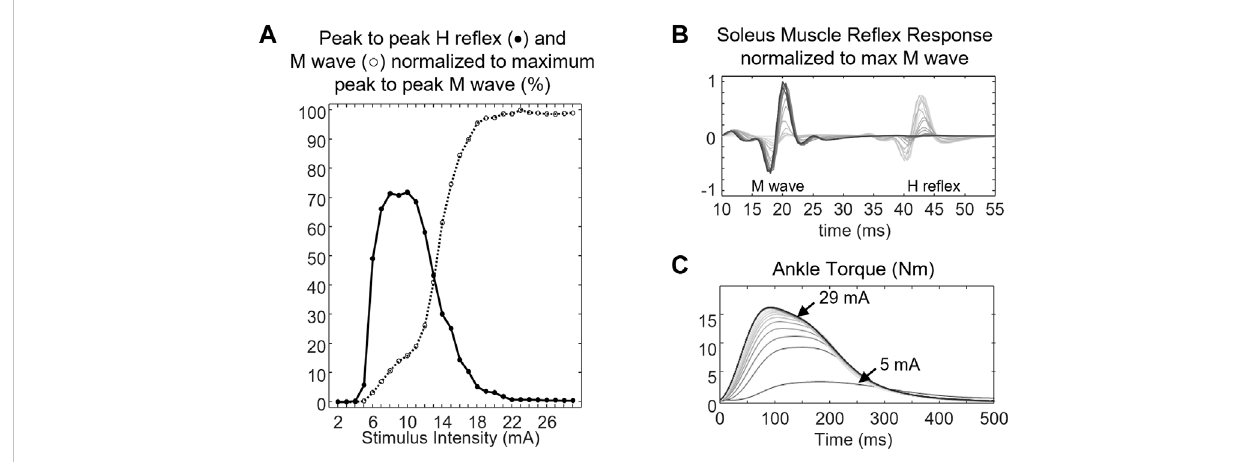
FIGURE 3 (A) peak-to-peak H re fl ex (closed circle, (cid:129) ) and M wave pro fi le (open circle, ○ ), (B) soleus muscle response, and (C) ankle torque of a representative subject. The ankle torqueincreased as the stimulus intensity delivered to thetibial nerve increased. Lines with darker colors denote muscle response and ankle torque at higher stimulus intensity.